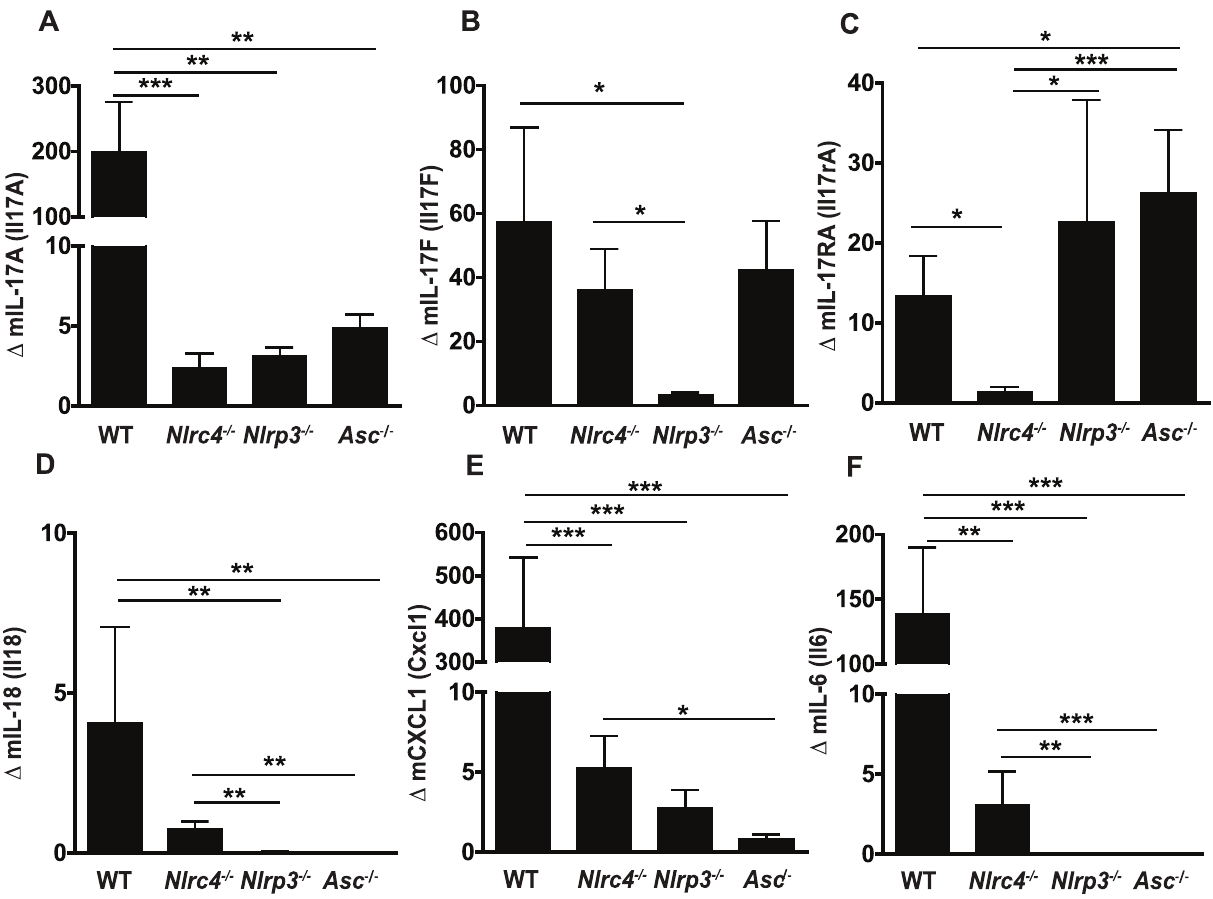
Figure 5. Inflammasome dependence of inflammatory cytokine responses in the oral mucosa following Candida infection. Induction of inflammatory genes in buccal mucosal tissues from WT, Nlrc4 2 / 2 , Nlrp3 2 / 2 , and Asc 2 / 2 mice after 72 h of infection with Candida albicans . (A) mIL-17A, (B) mIL-17F, (C) mIL-17RA, (D) mIL-18, (E) mKC/CXCL1 and (F) mIL-6. All genes normalized to GAPDH. (*** P # 0.001; ** P # 0.01; * P # 0.05).